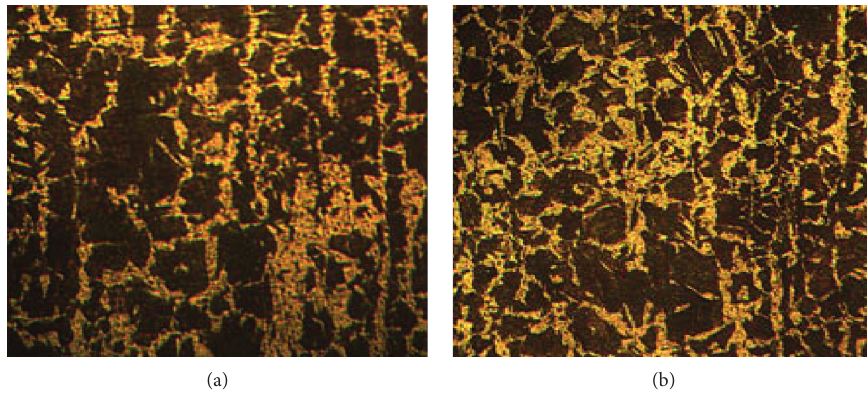
Figure 16: Friction stir welding samples under (a) dry and (b) cryogenic